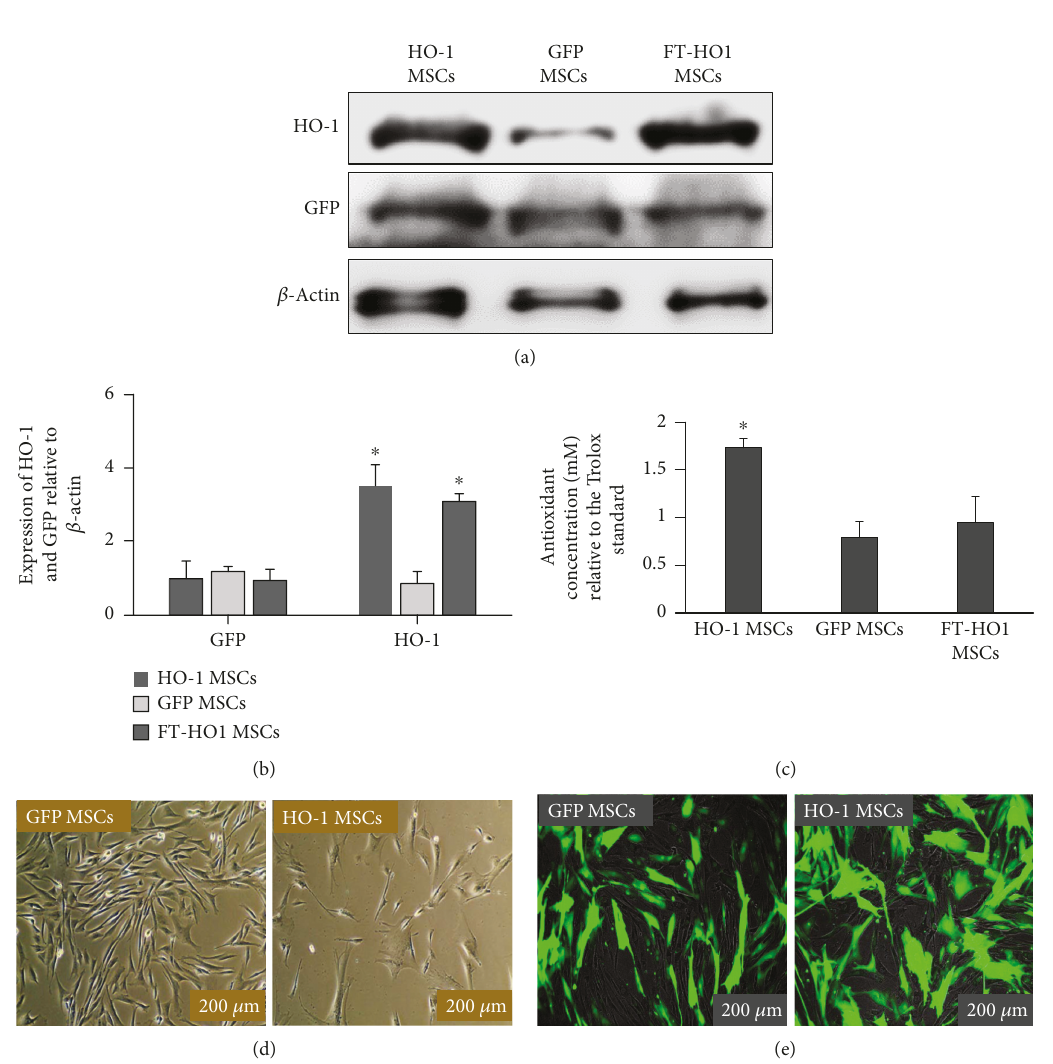
Figure 2: HO-1 and GFP gene transfection in Ad-MSCs. (a) Representation of the densities of HO-1 and GFP proteins obtained from a cell lysate of HO-1 and GFP MSCs. (b) Quantitative expression of densities obtained by western blot relative to β -actin. Each bar represents the average of six samples and error bars represent standard error. (c) Measurement of antioxidant concentration (mM) compared to Trolox standard curve. Each bar represents the average of six samples and error bars represent standard error. ∗ Indicates signi fi cance at p ≤ 0 05 (Student t - test). (d) Positive GFP expression by GFP and HO-1